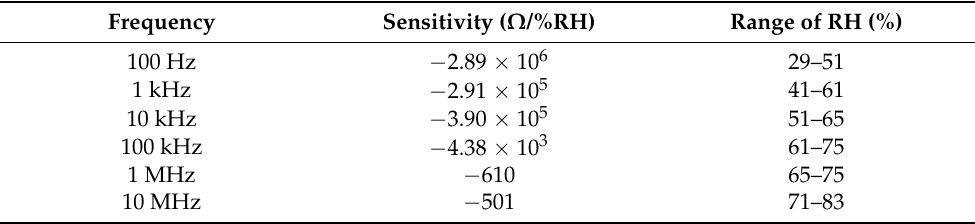
Table 2. Sensitivity of the sensor in the linear response for the different frequencies and range of RH of the linear phase.